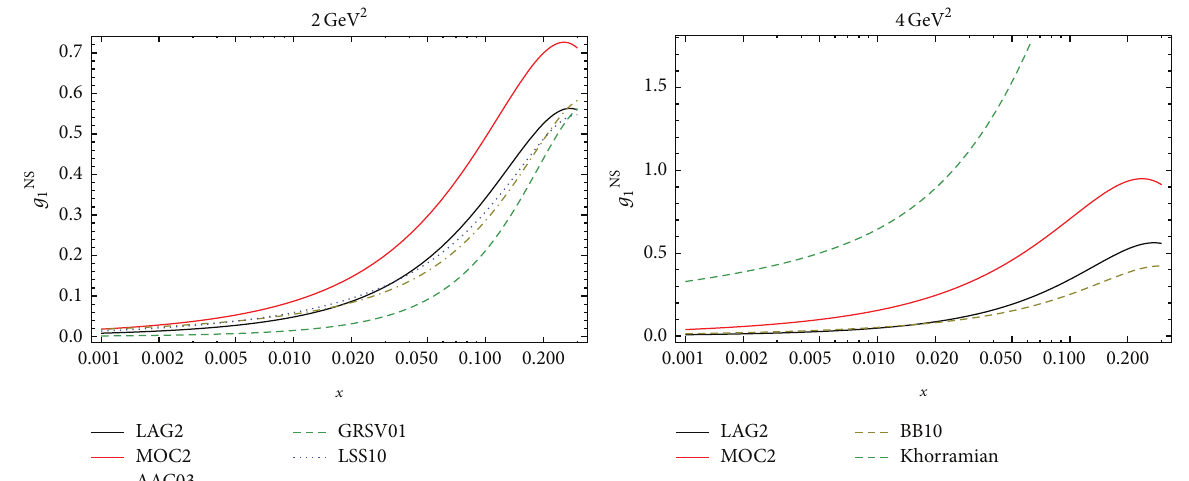
Figure 3: 𝑔 NS 1 (𝑥,𝑡) from (25) and (52) as function of 𝑥 at 𝑄 2 = 2, 4 GeV 2 , respectively, at